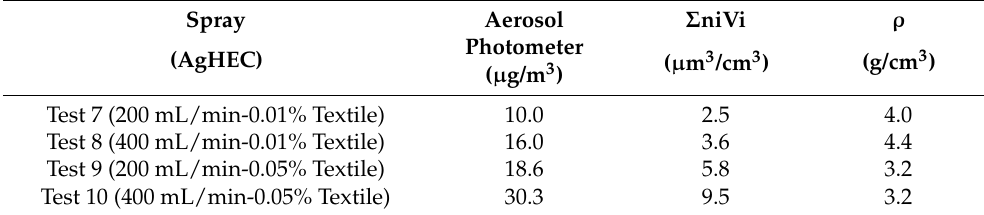
Table 3. AgHEC sprays. Aerosol mass concentrations were determined by aerosol photometer, while total particle volume was obtained with the OPC. All the data refer exclusively to spray spikes. The aerosol photometer data were corrected by the gravimetric correction factor.